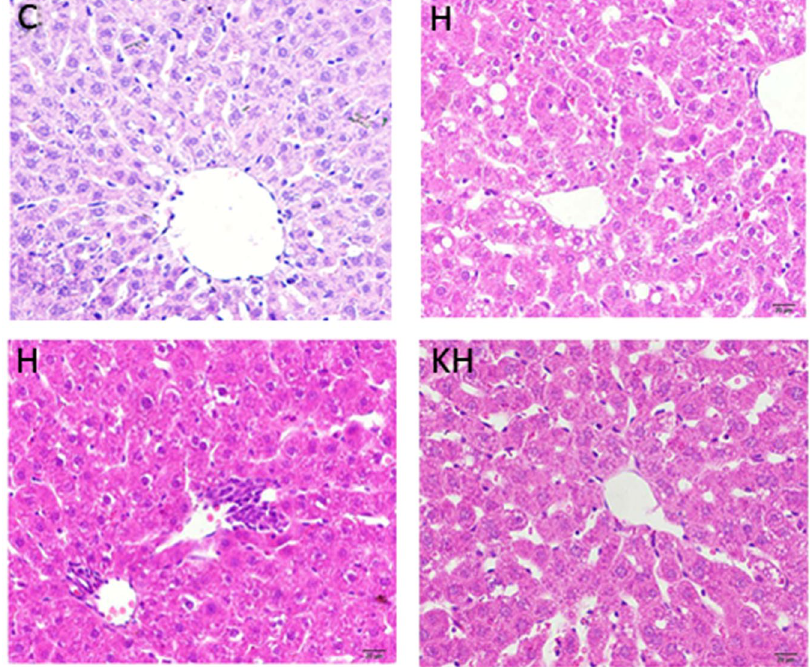
Figure 1. Light microscopy showing normal liver tissue in the control group (HE staining, × 100) ( A ); hepatocyte steatosis in H group ( B ); inflammatory cells and cellular edema in the heat stress group ( C ) and Kisspeptin group ( D ) (HE staining, × 100). C: control group; H: Heat stress group; KH: Kisspeptin + Heat stress